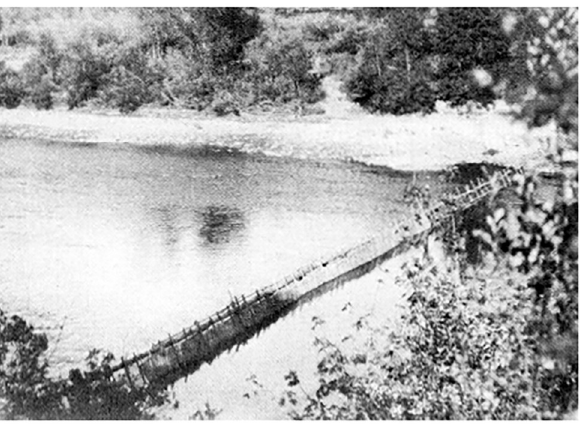
Fig 4. Hupa salmon weir on lower Trinity River, After P. E. Goddard, Life and Culture of the Hupa, University of California Publications American Archaeology and Ethnology 1, 1–88 (1903).